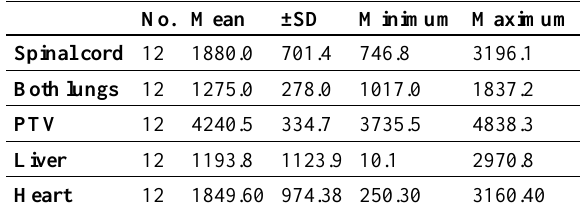
Table 4. Radiotherapy doses (in cGy) No. Mean ±SD